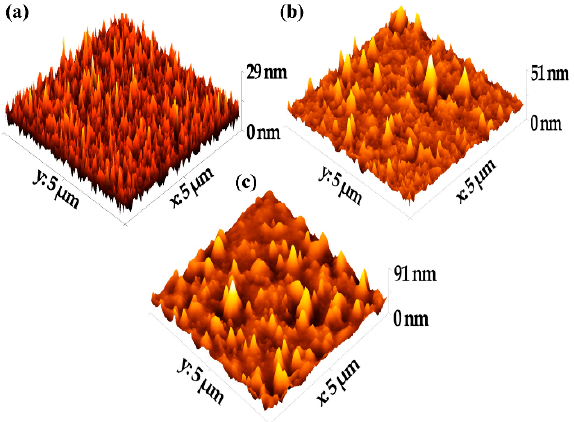
Figure 2. Typical 3D AFM images: ( a ) uncoated glass substrate; ( b ) 90 wt% of [EMIM]Cl-doped asphaltene thin film; ( c ) undoped asphaltene thin film.